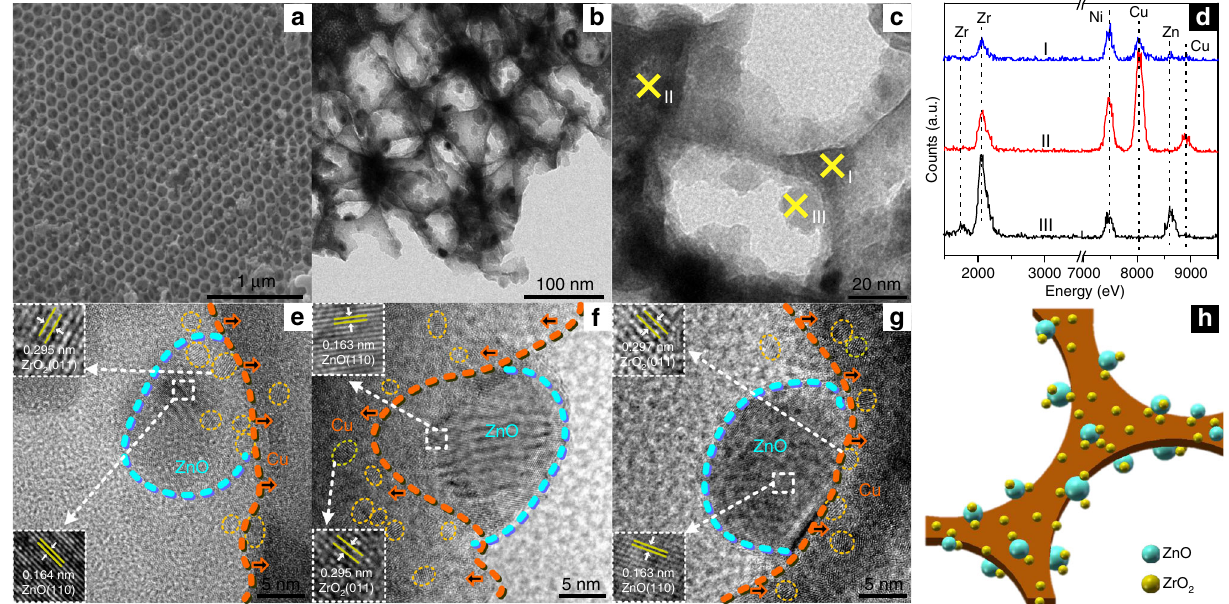
Fig. 1 Morphological and compositive characterizations of a 3DOM CZZ catalyst (M-CZZ(16)). a SEM image, indicating an average pore size of 120 nm. b , c TEM images of the M-CZZ(16) sample, which shows the smallest ZnO particle size (15.8 nm) in the 3DOM catalyst series. d EDS of different points in c . e – g HRTEM images of M-CZZ(16). h Structural diagrammatic sketch of the macroporous catalysts